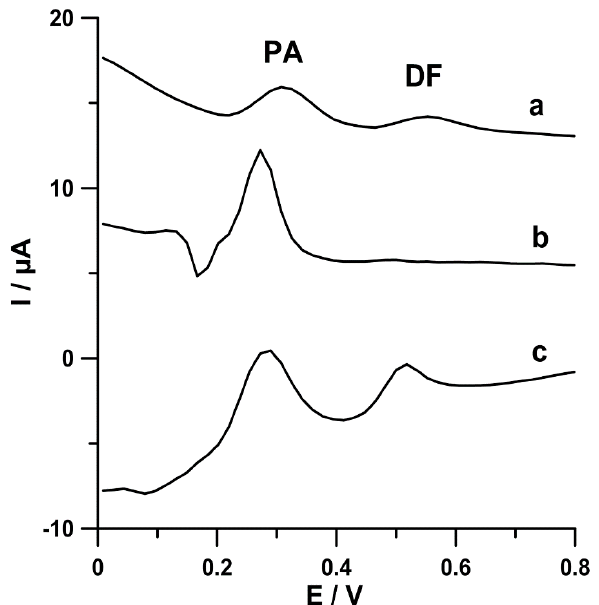
Figure 2. Differential-pulse adsorptive stripping voltammetric (DPAdSV) curves of PA (2.0 × 10 − 6 mol L − 1 ) and DF (2.0 × 10 − 8 mol L − 1 ) in 0.1 mol L − 1 acetate buffer solution of pH 4.0 ± 0.1 at SPCE (a),